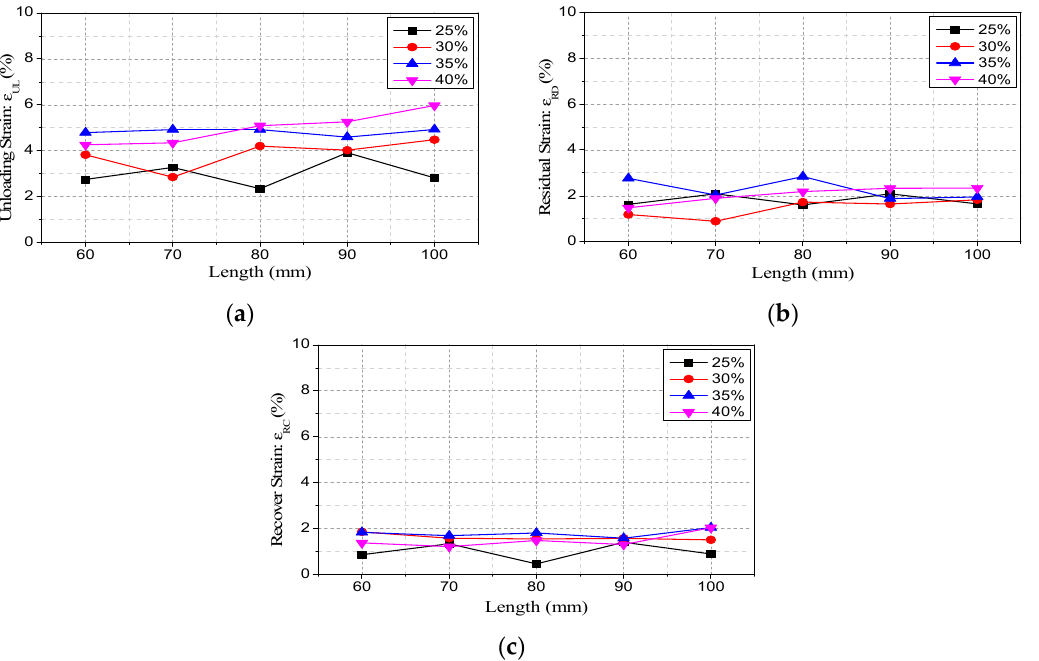
Figure 10. Behavior of three types of strain corresponding to each maximum strain in Type1. ( a ) Unloading strain; ( b ) residual strain; ( c ) recover strain.